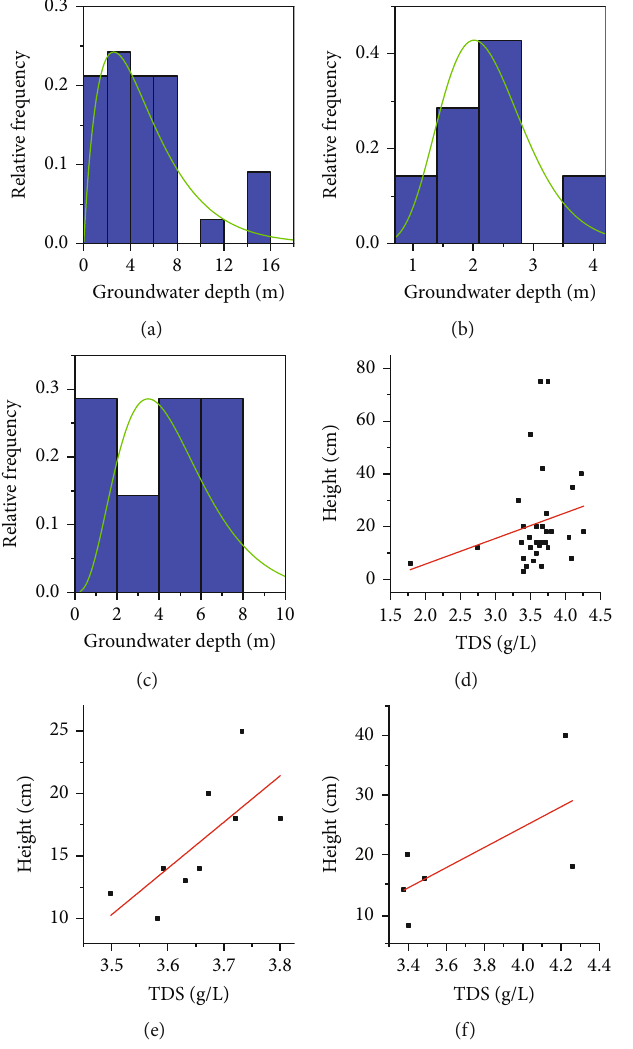
Figure 6: The e ff ect of groundwater characteristics on natural vegetation. Depth: (a) all; (b) Kalidium foliatum ; (c) Leymus chinensis ; TDS: (d) all; (e) Kalidium foliatum ; (f) Leymus chinensis .